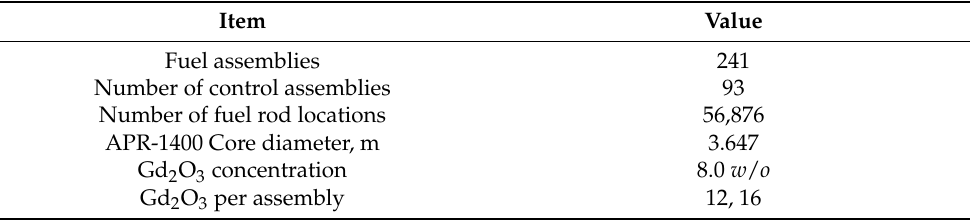
Table 1. APR-1400 core design parameters